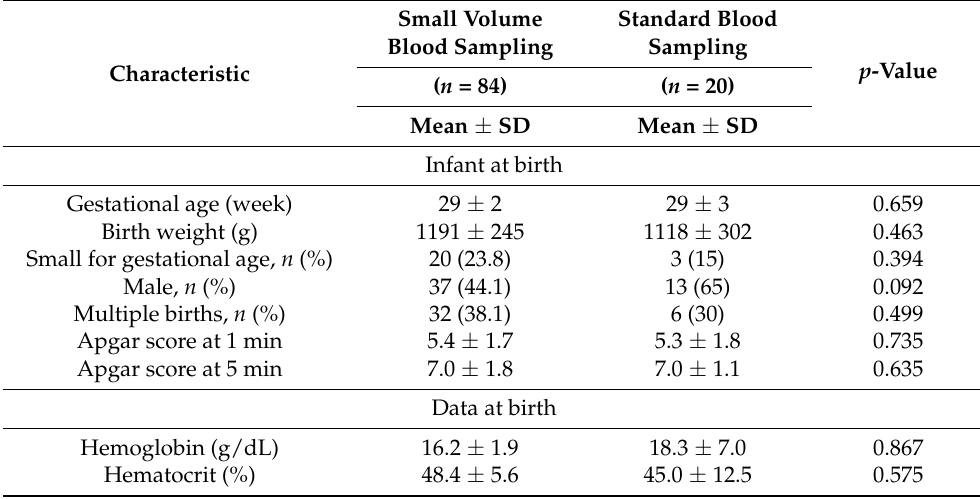
Table 1. Patient characteristics between the two